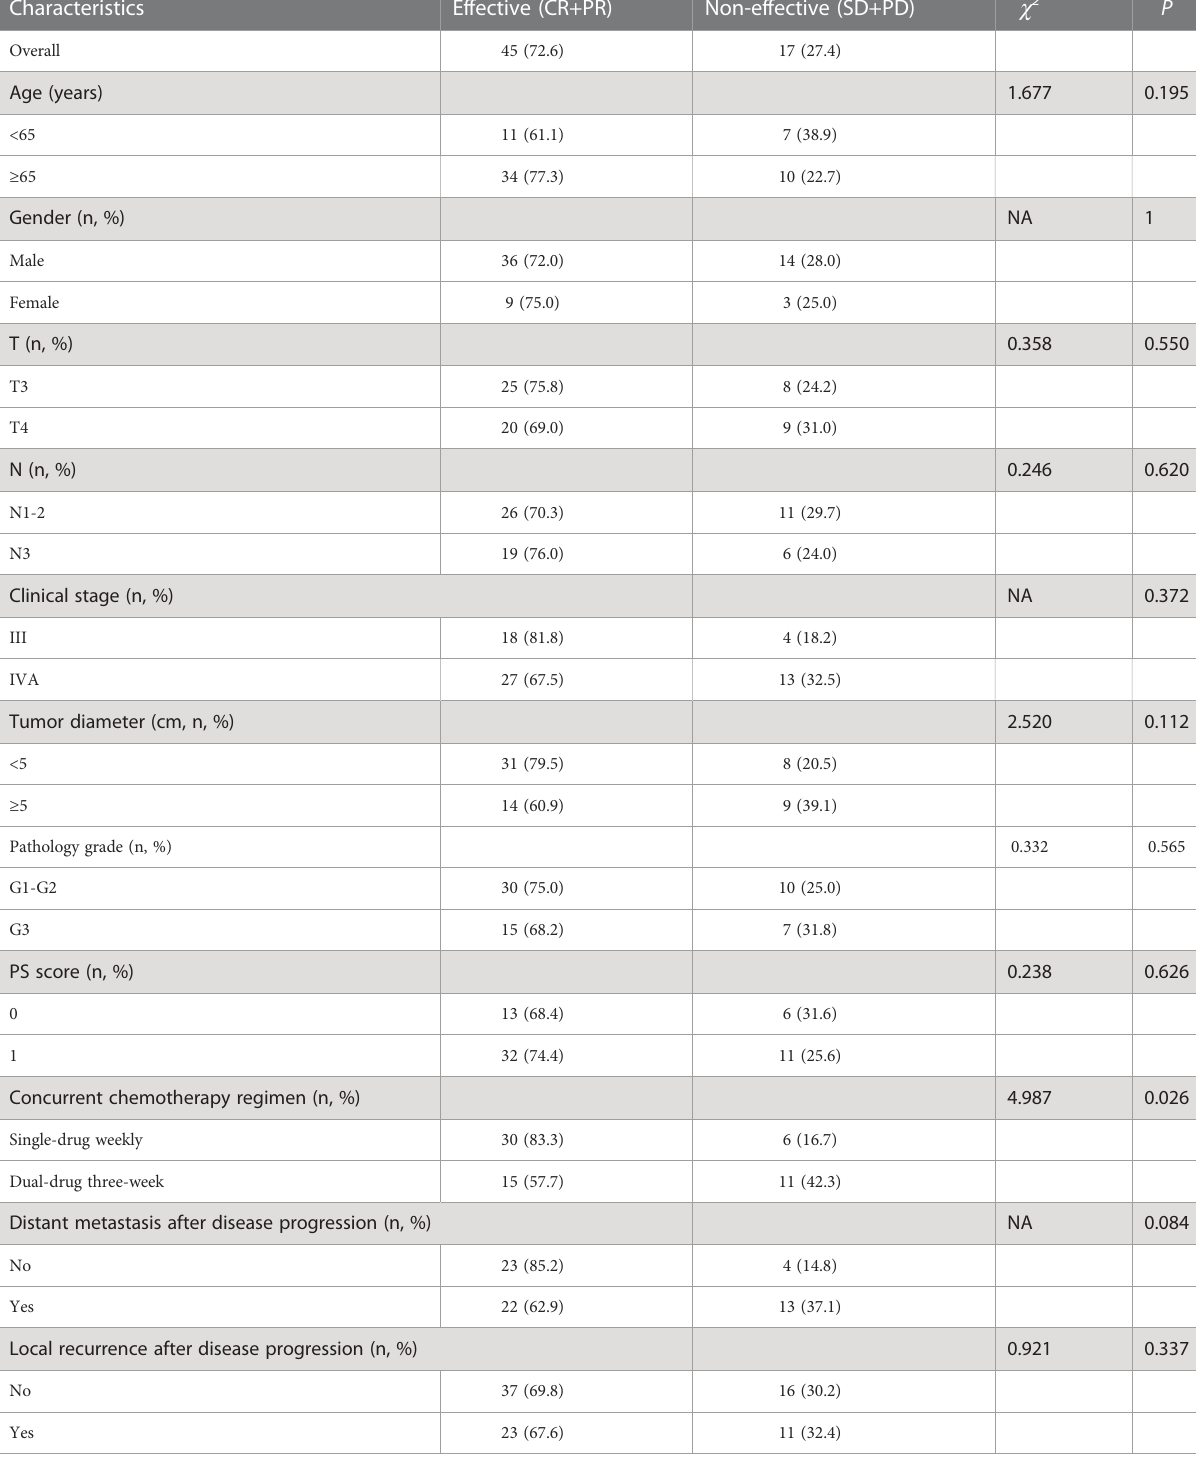
TABLE 3 Evaluation of short-term chemotherapy in the IC+CRT